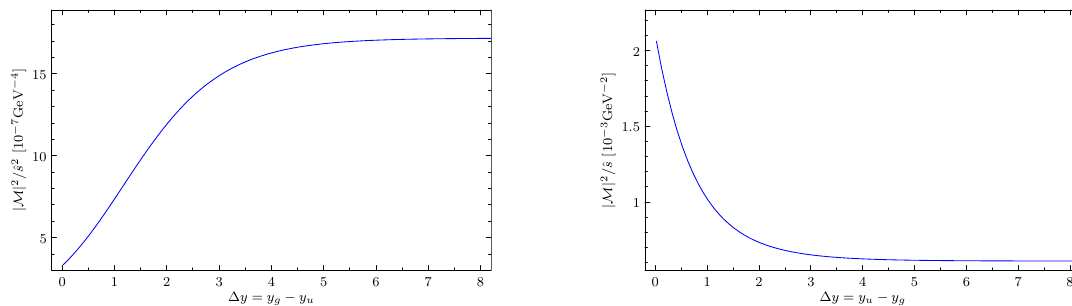
Figure 1. Regge scaling of quark-gluon scattering amplitudes in the MRK limit, approached by increasing ∆ y . Left: rapidity ordering qg → qg . Right: rapidity ordering qg → gq . The kinematics are fixed by the azimuthal angle φ 1 = π and transverse momentum p 1 ⊥ = 40 GeV of the outgoing 7 particle in the backward